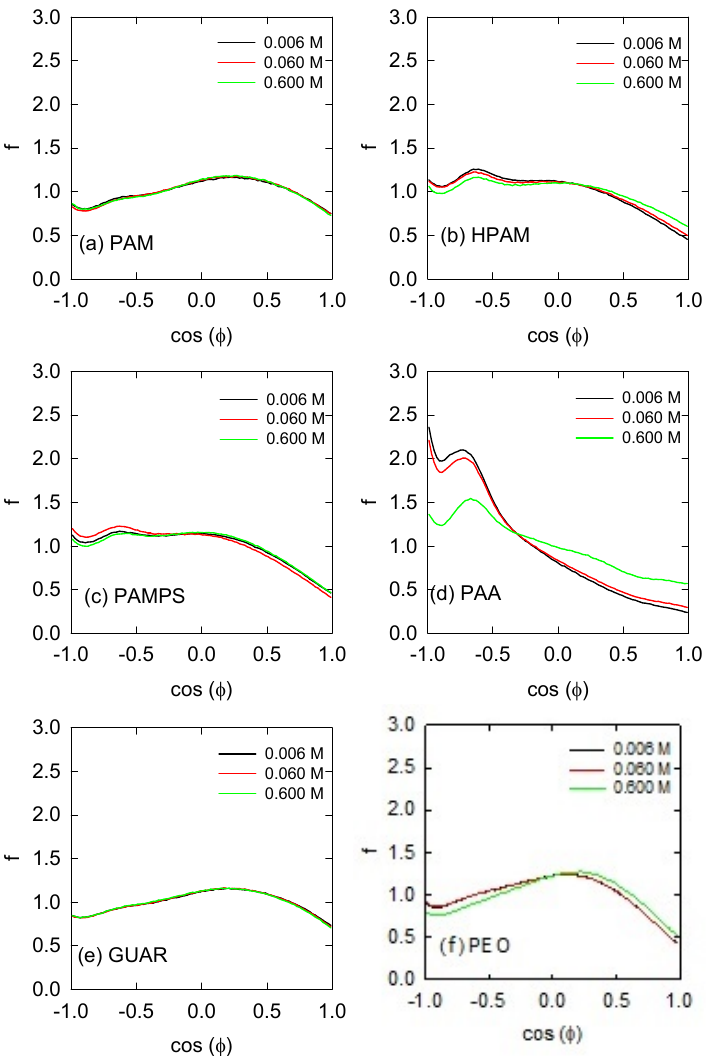
Figure 5. Orientation of water molecules around the polymers at different NaCl concentrations. ( a ) polyacrylamide, ( b ) hydrolyzed polyacrylamide, ( c ) 2-acrylamido-2-methyl-1-propanesulfonic acid, ( d ) polyacrylic acid, ( e ) guar gum, ( f ) polyethylene oxide.